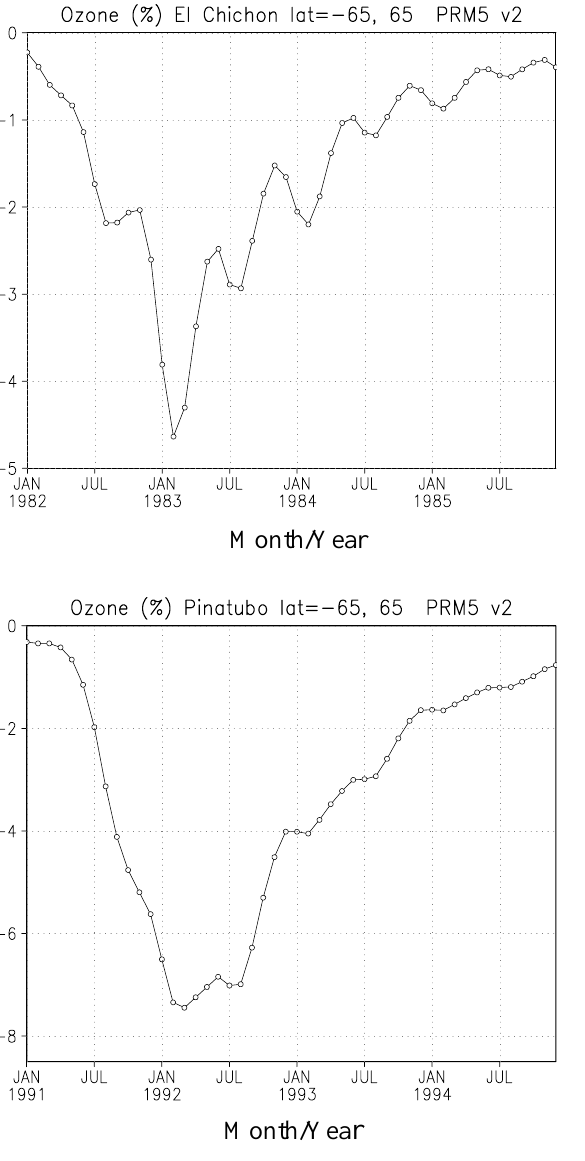
Fig. 19 Evolution of the global total ozone after the El Chichón eruption from 1982 to 1985 (upper) and Pinatubo eruption from 1991 to 1994 (lower) for the simulation (left) and observation (TOMS/SBUV) (right).